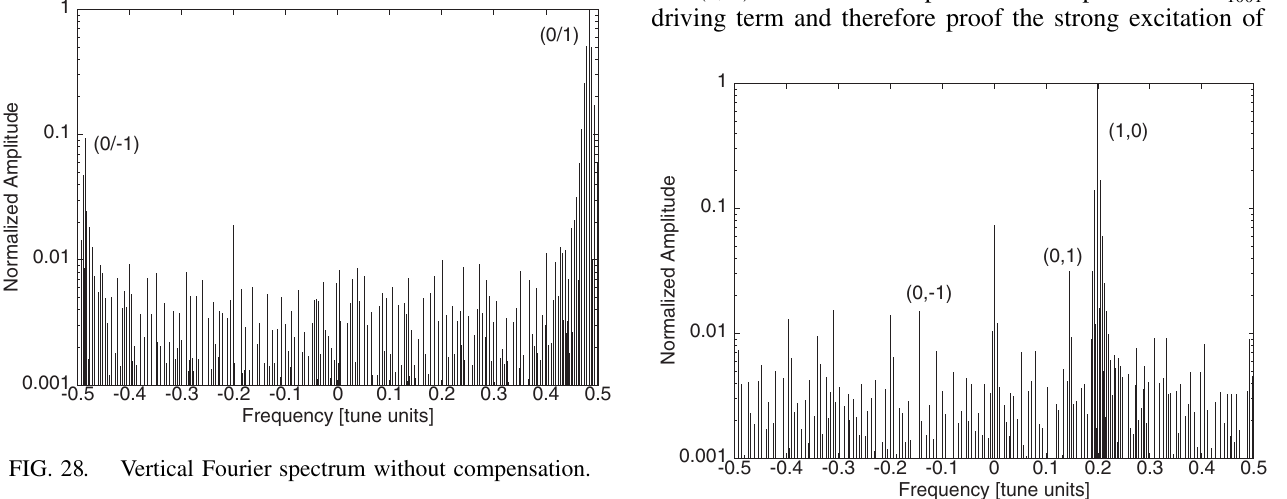
FIG. 28. Vertical Fourier spectrum without compensation.